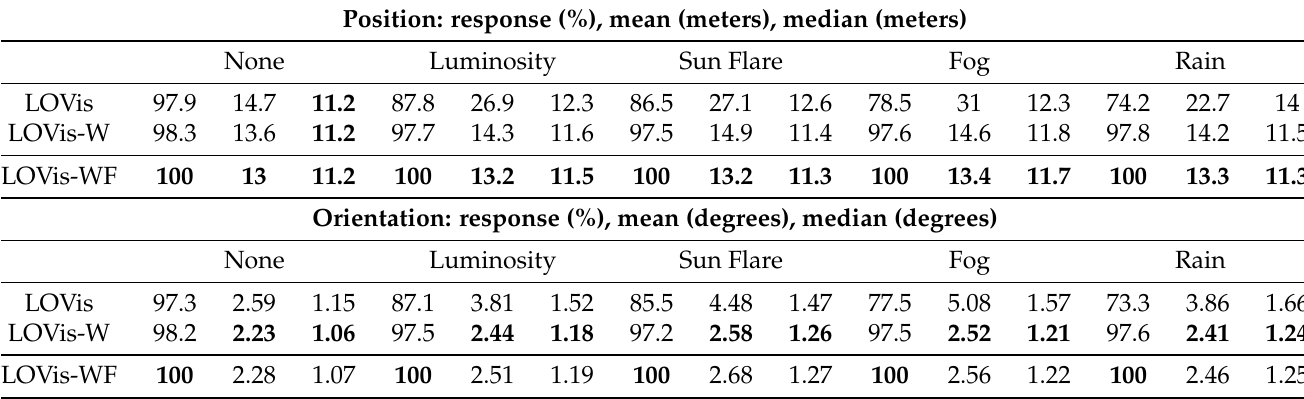
Table 4. Results for 3-DOF pose prediction on various environmental conditions. The best performances are shown in bold. Position: response (%), mean (meters), median